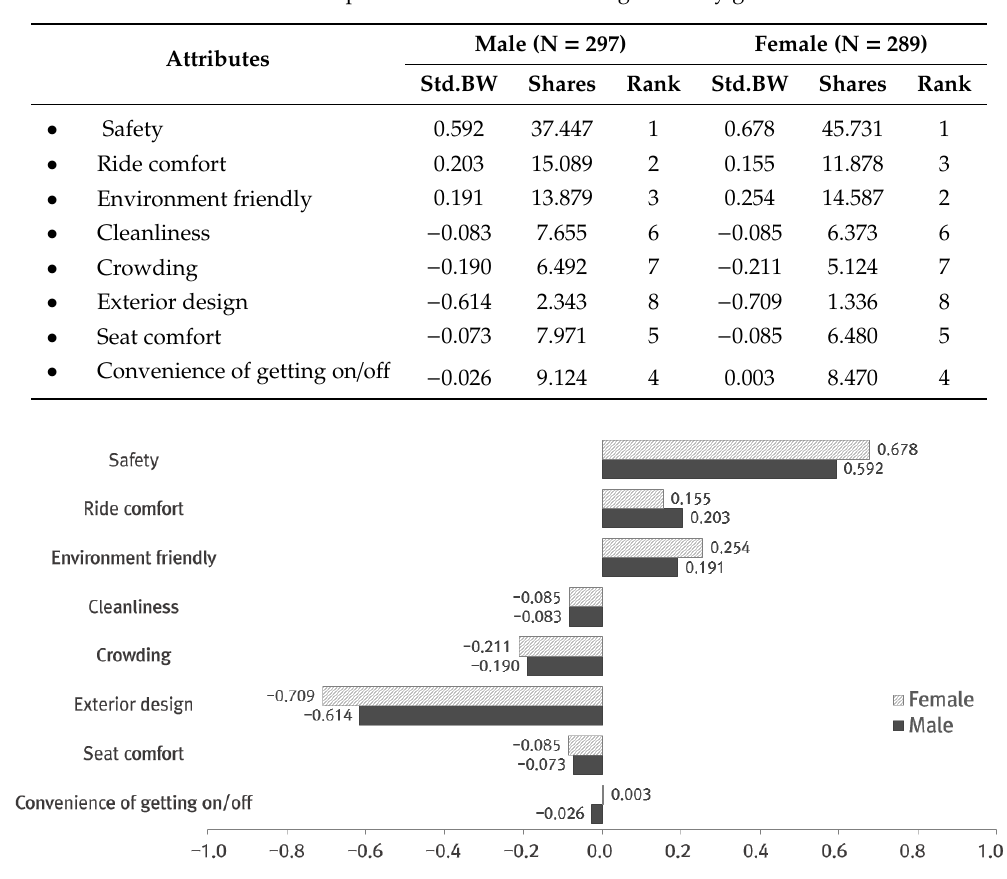
Figure 1. Comparison of standardized BW score by gender.